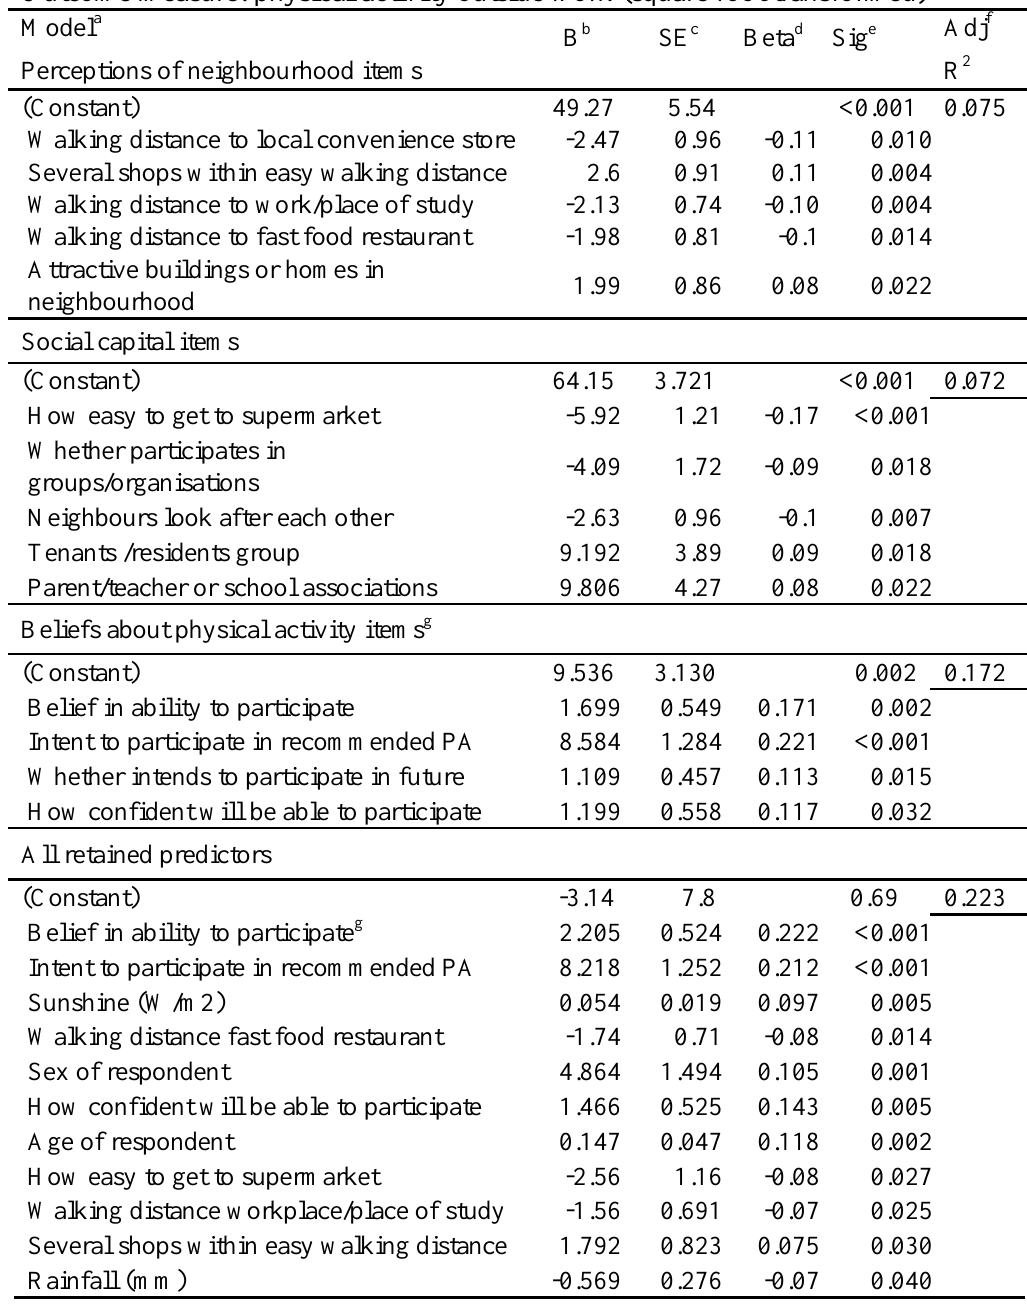
Table 5. Summary of the multiple linear regression model fits to individual constituent questionnaire